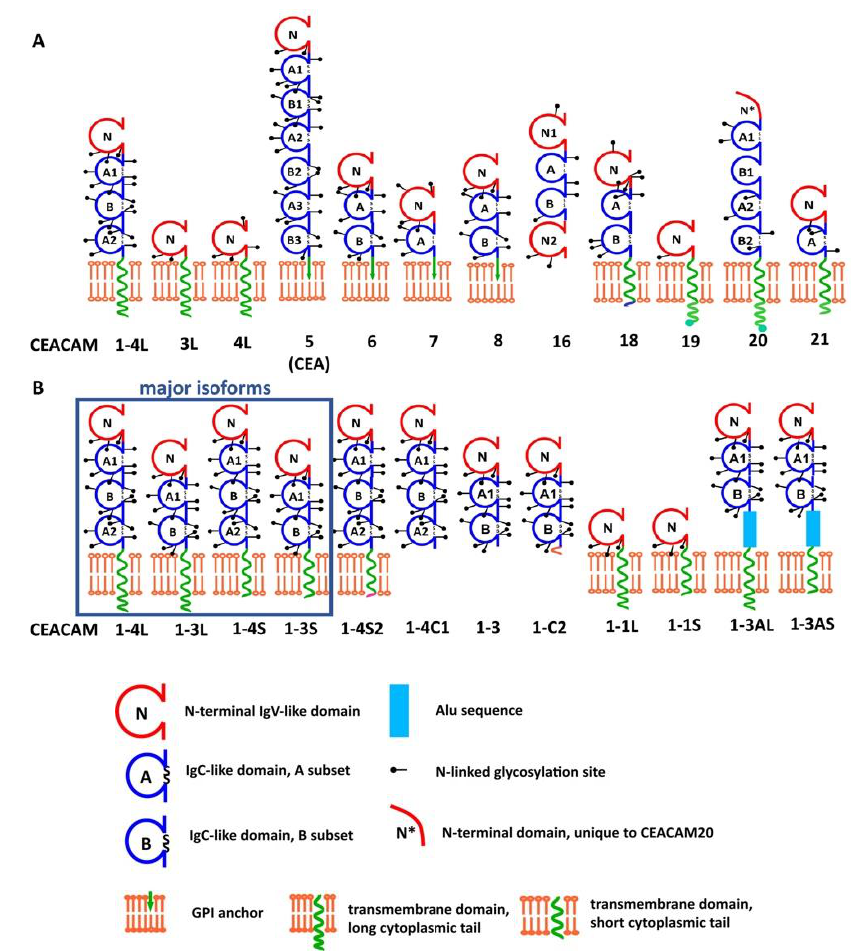
Figure 1. Structural representation of human CEACAM proteins and CEACAM1 splice variants. ( A ) In humans, there are 12 different CEACAM genes that encode functional proteins: CEACAM1, CEACAM3, CEACAM4, CEACAM5 (CEA), CEACAM6, CEACAM7, CEACAM8, CEACAM16, and